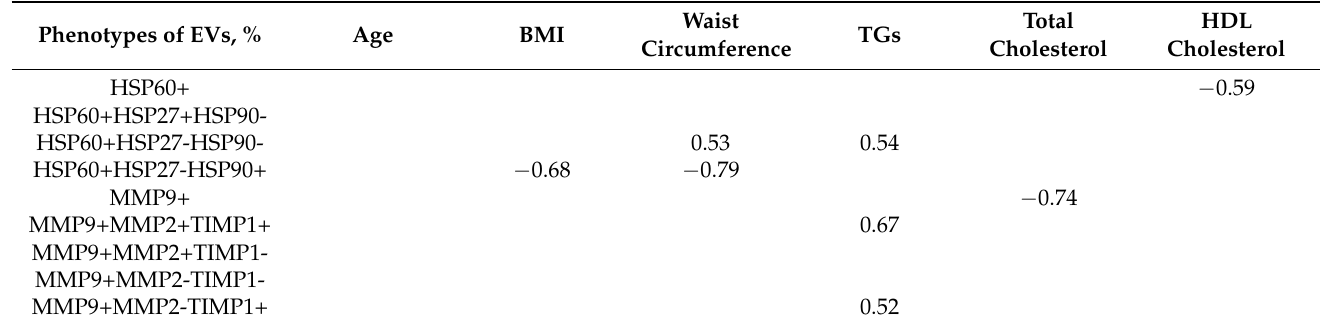
Table 4. Spearman correlation coefficients (r) between FABP4-positive sEVs phenotypes and age, BMI, waist circumference, TGs, total cholesterol, and HDL cholesterol in